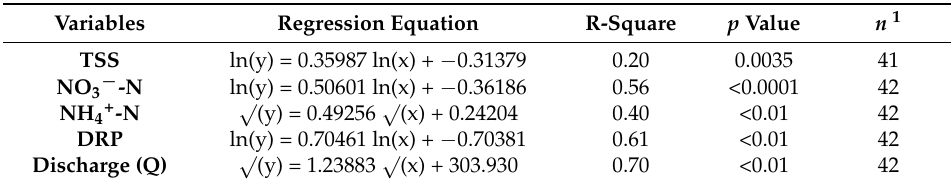
Table 3. Equations used to calculate Event Mean Concentrations (EMCs) established from runoff events collected during the calibration period.